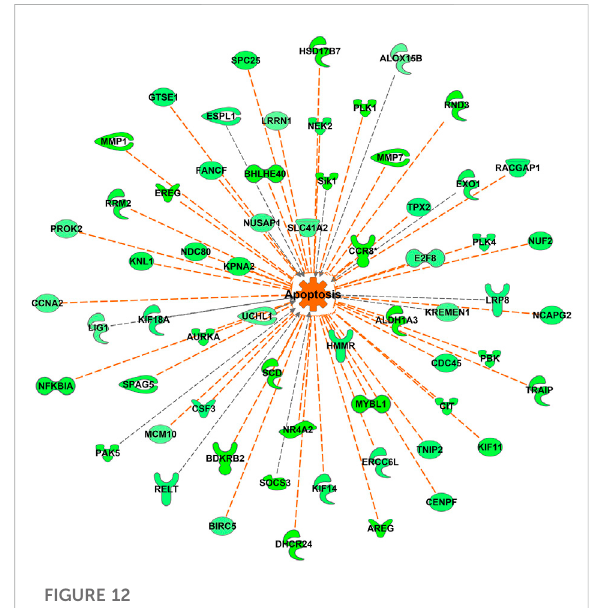
Apoptosis-associatedgenesdifferentiallyexpressedbetween DLY and FED chicks. Many genes associated with apoptosis and cell viability were differentially expressed (fold-change ≥ 5; FDR p -value ≤ 0.05) between DLY and FED chicks. Expression patterns suggest there is increased apoptosis in the livers of DLY chicks compared to FED chicks. Green molecules signi fi cantly downregulated in DLY chicks. Orange indicates predicted